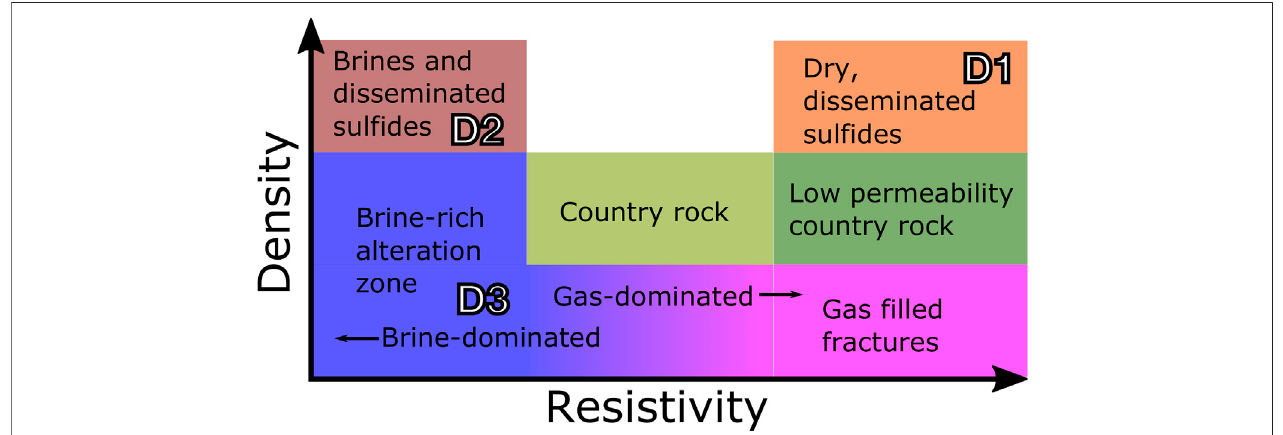
FIGURE 9 | Interpretation of models in density-resistivity space. Different colored boxes represent different lithologies in our interpretation. Regions with non- anomalous density and resistivity represent country rock. Regions with low resistivity and high density (D2, Figure 8 ) we interpret as brines and disseminated sul fi des. Regionswithhighresistivityandlowdensitymayrepresentdisseminatedsul fi deswithoutsaline fl uids(D1, Figure8 ).Thelowdensityareas(D3, Figure8 )weinterpretas gas fi lled fractures where resistivity is high, and brine-dominated alteration zones where resistivity is low. Neutral density areas with high resistivity may represent country rock with lower